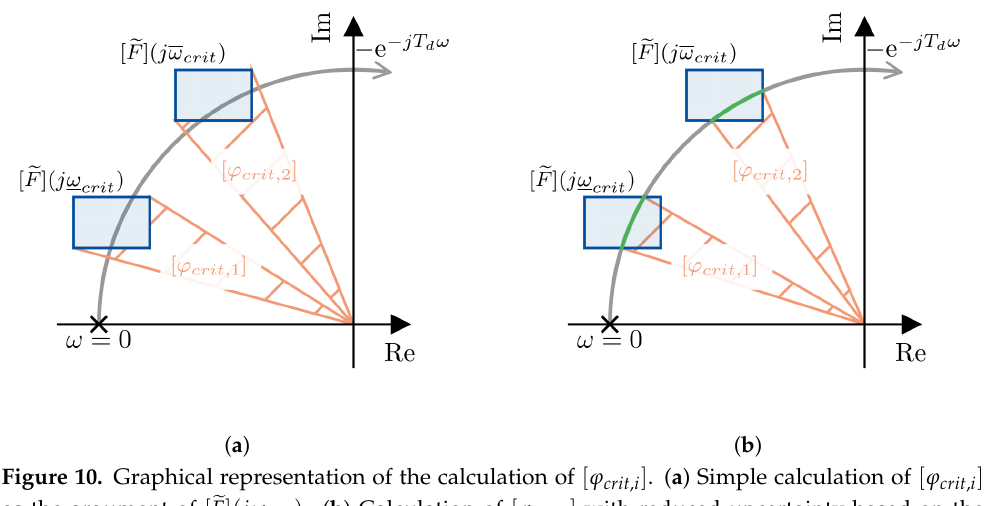
Figure 10. Graphical representation of the calculation of [ ϕ crit , i ] . ( a ) Simple calculation of [ ϕ crit , i ] as the argument of [ (cid:101) F ]( j ω crit ) . ( b ) Calculation of [ ϕ crit , i ] with reduced uncertainty based on the intersections of [ (cid:101) F ]( j ω crit ) with the unit